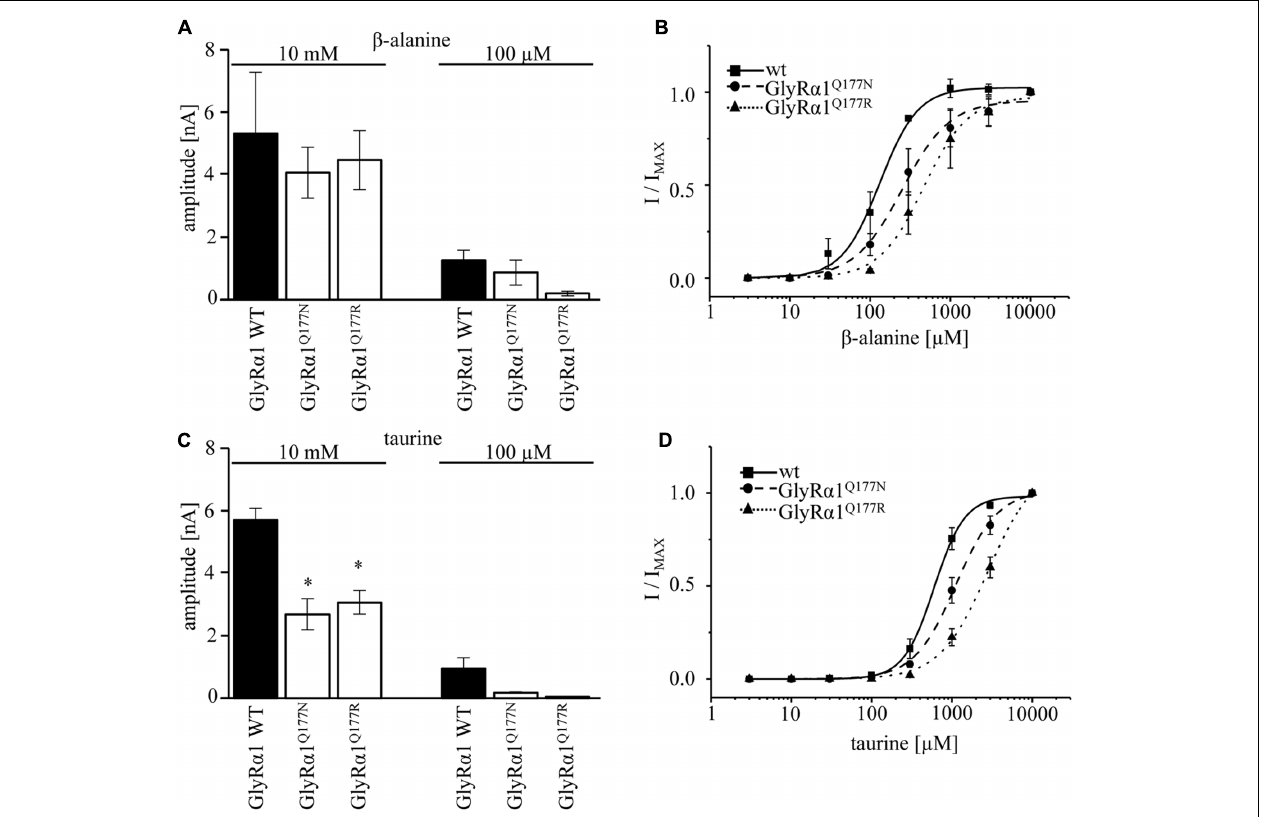
FIGURE 5 | GlyR α 1 Q177 variants result in changes in potency and efficacy of the partial GlyR agonists β -alanine and taurine. GlyR α 1 Q177 variants were coexpressed with GlyR β WT. (A) Comparison of the absolute current amplitudes ( I ) between GlyR α 1 WT, GlyR α 1 Q177N , GlyR α 1 Q177R at a saturating β -alanine concentration of 10 mM and at 100 µ M. (B) Dose–response curves for GlyR α 1 WT and the GlyR α 1 mutants using β -alanine at different concentrations (3–10000 µ M). (C) Determination of taurine efficacy at saturating concentration of taurine 10 mM and at 100 µ M. Absolute current amplitudes ( I ) are shown; level of significance ∗ p < 0.05. (D) Dose–response curves of taurine (3–10000 µ M) for GlyR α 1 WT, GlyR α 1 Q177N , and GlyR α 1 Q177R